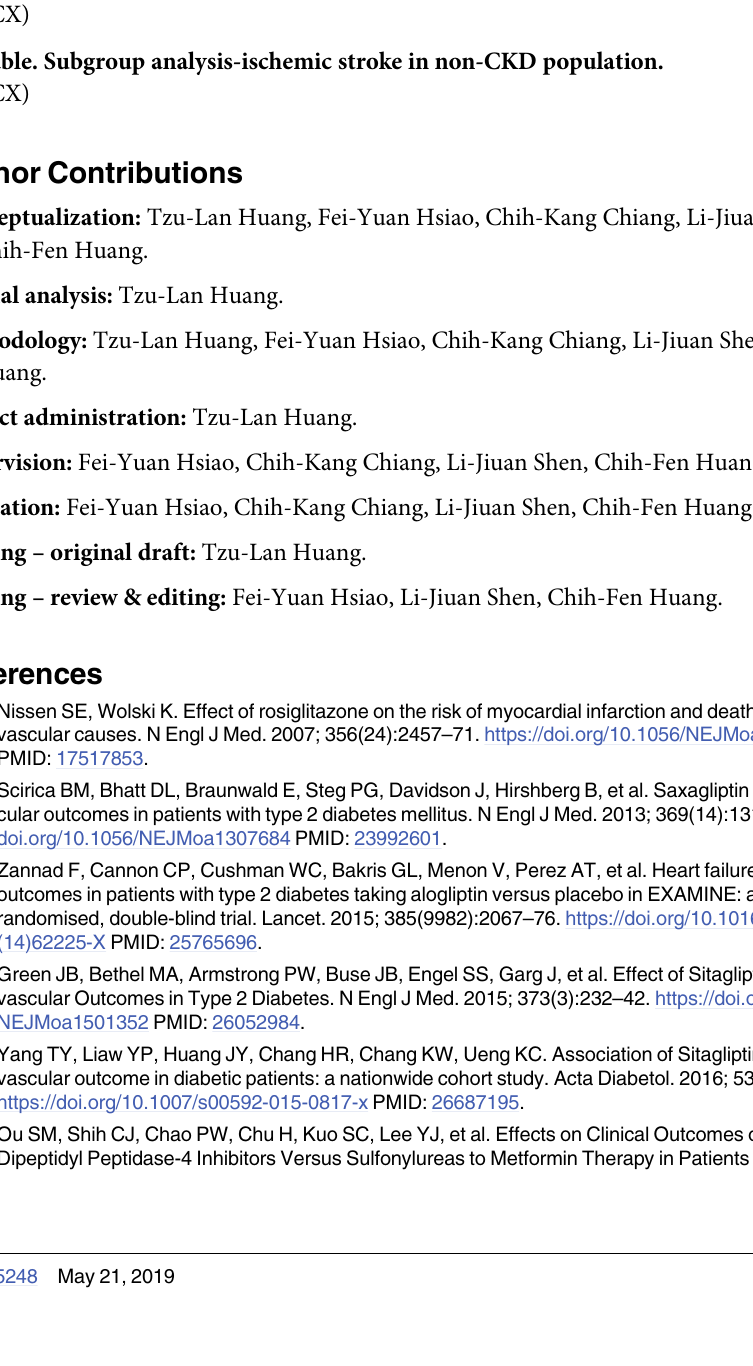
S2 Table. CKD definition: Diagnosis codes and dialysis codes. (a) CKD-related diagnosis